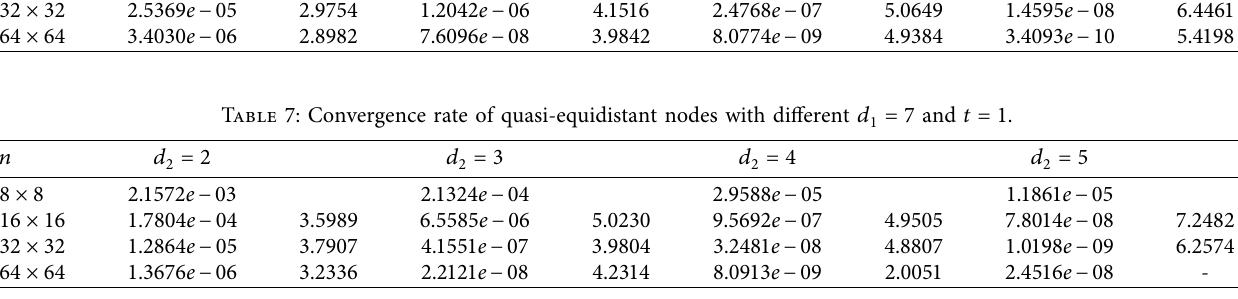
Table 8: Convergence rate of quasi-equidistant nodes with different d